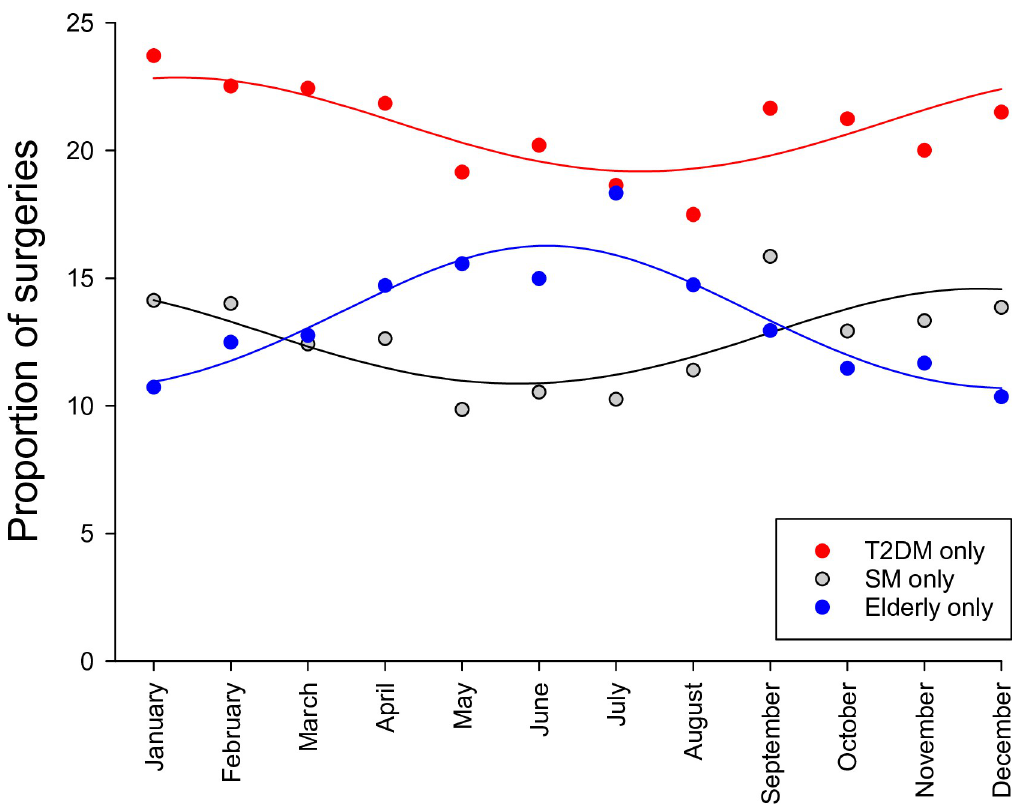
Fig 2. Seasonal changes in the proportion of surgeries associated with type 2 diabetes mellitus (T2DM only), smoking (SM only), and aging (Elderly only) for the monthly aggregated data over the 12-year study period (January 1, 2007 to December 31,